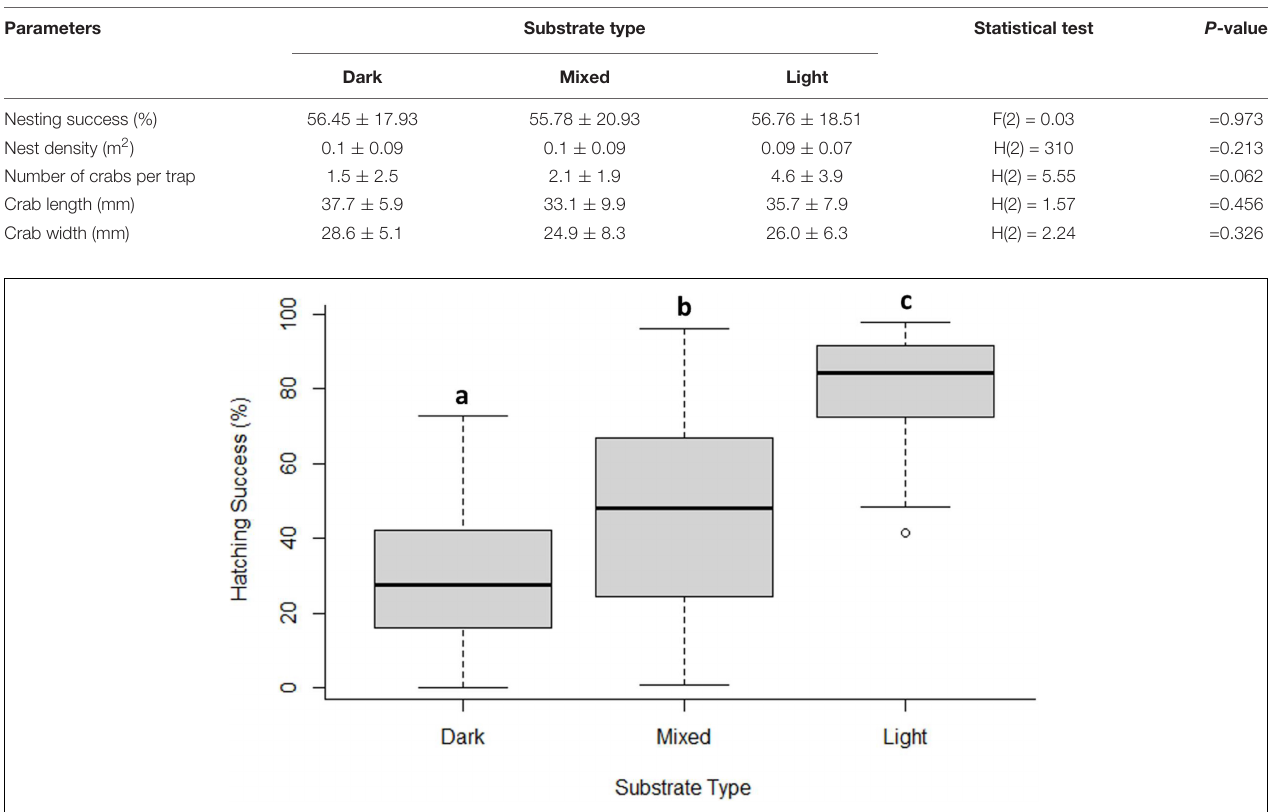
FIGURE 2 | Hatching success in different substrates (dark, mixed, and light) under controlled incubation conditions in the hatchery. Different lowercase letters indicate statistically significant differences among treatments. The median is the bold line as a measure of central tendency, quartiles one (Q1) and three (Q3) marked by upper and lower box limits and maximum (max) and minimum (min) values marked with whiskers above and below.